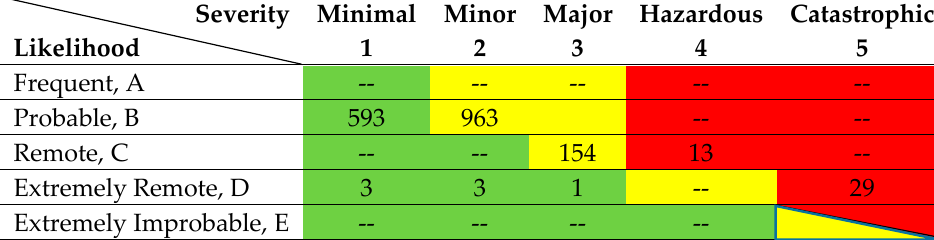
Table 16 . Risk matrix with look ‐ ahead time 60 s, overtaking scenario.06 Table 16 . Risk matrix with look-ahead time 60 s, overtaking scenario. Table 16 . Risk matrix with look-ahead time 60 s, overtaking scenario. Table 16 . Risk matrix with look-ahead time 60 s, overtaking scenario. Table 16. Risk matrix with look-ahead time 60 s, overtaking scenario.